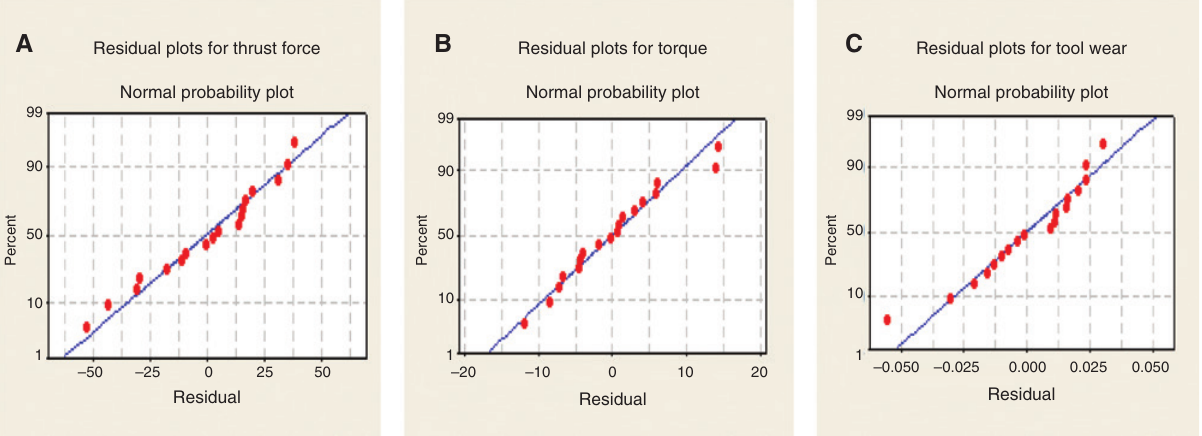
Figure 7: (A) Normal probability plot for thrust force, (B) normal probability plot for torque, and (C) normal probability plot for tool wear.